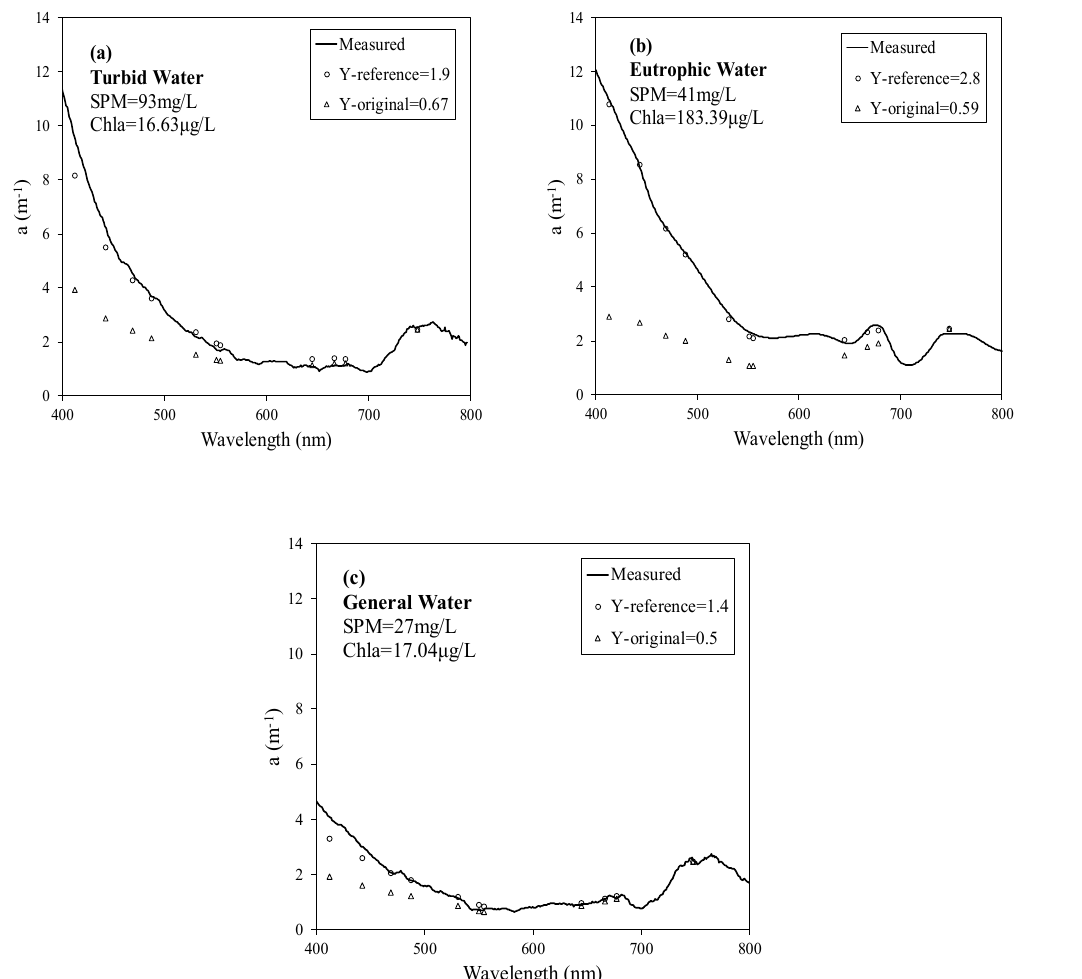
Figure 4. Comparison of measured total absorption coefficients with derived values of different Y values in the cases of ( a ) turbid, ( b ) eutrophic, and ( c ) general water.